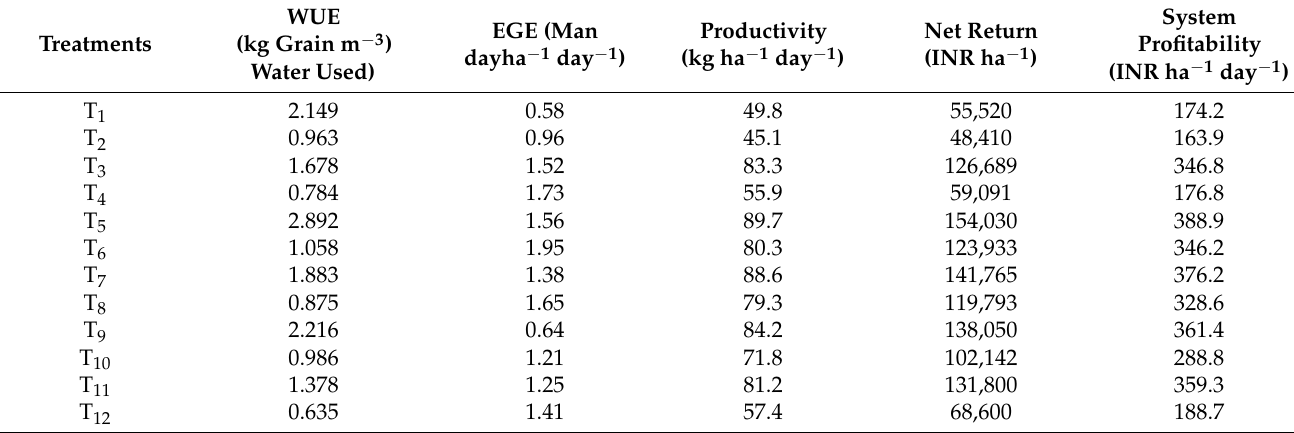
Table 4. Water use efficiency, employment generation efficiency, productivity, net return, and system profitability of experimental treatments.